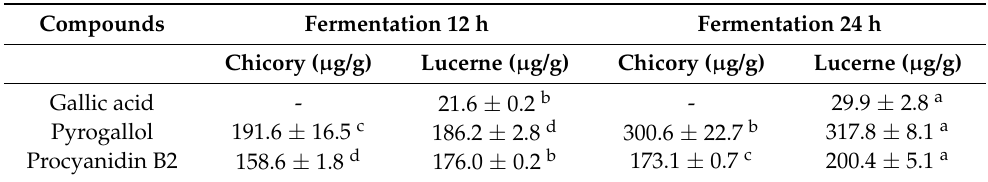
Table 3. Contents of individual polyphenols after 12 h or 24 h cecal fermentation of chicory and